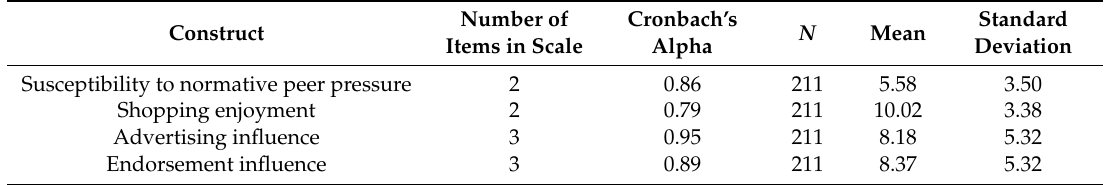
Table 2. Peer influence and marketing